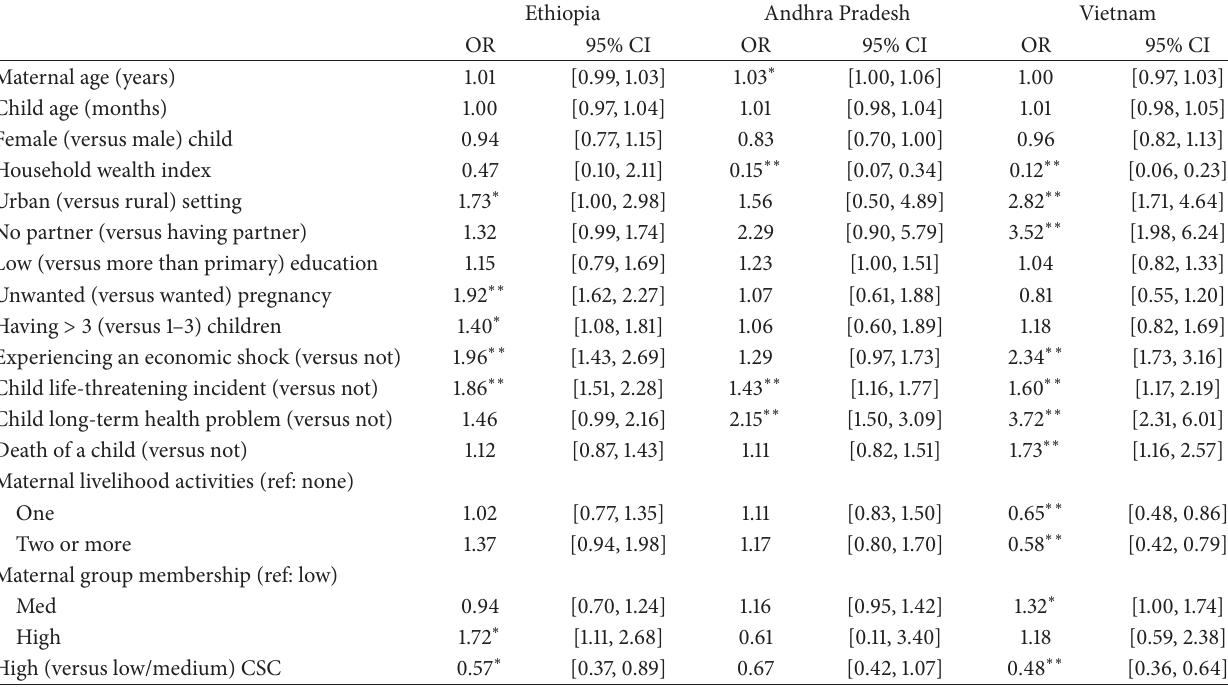
Table 3: Correlates of maternal